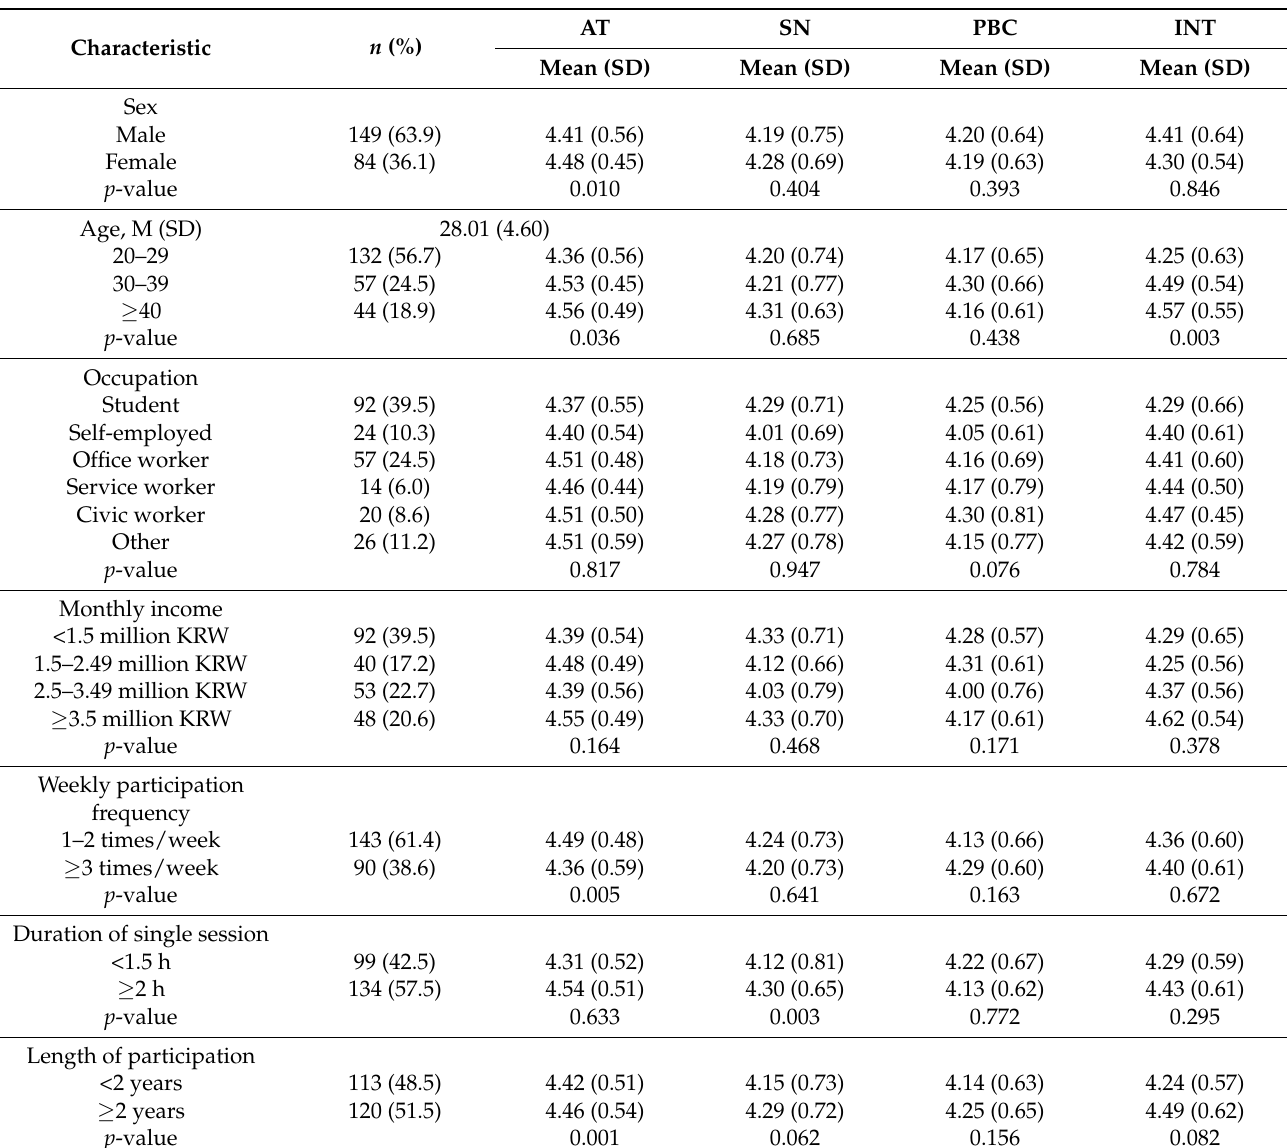
Table 2. Demographic characteristics of fencing club members ( n = 233).